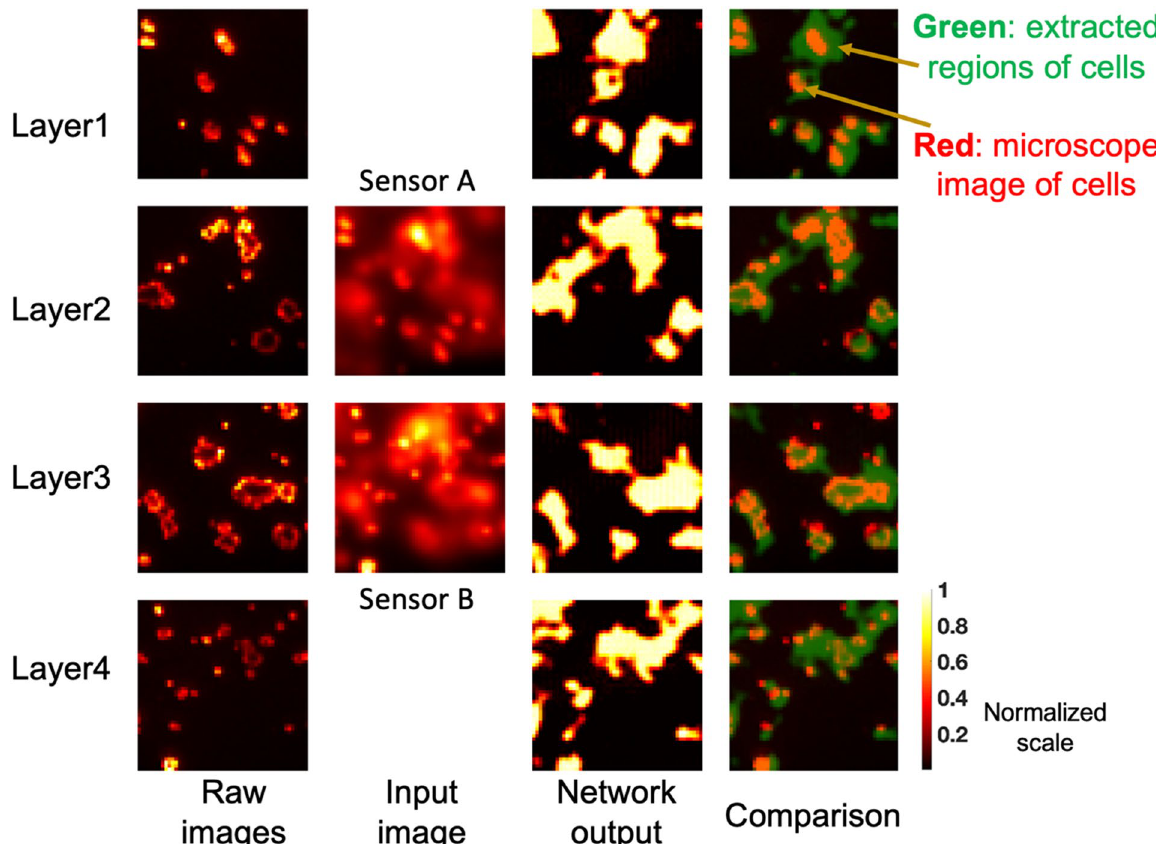
Figure 7. Evaluation of the CNN with two sensors on real-life cancer cell slides: (from leftmost to rightmost column) input images from 4 raw microscope images corresponding to each layer before applying the PSF, sensor images, network output images showing regions where cells were detected, and overlay composite image of network output and microscope images for each corresponding